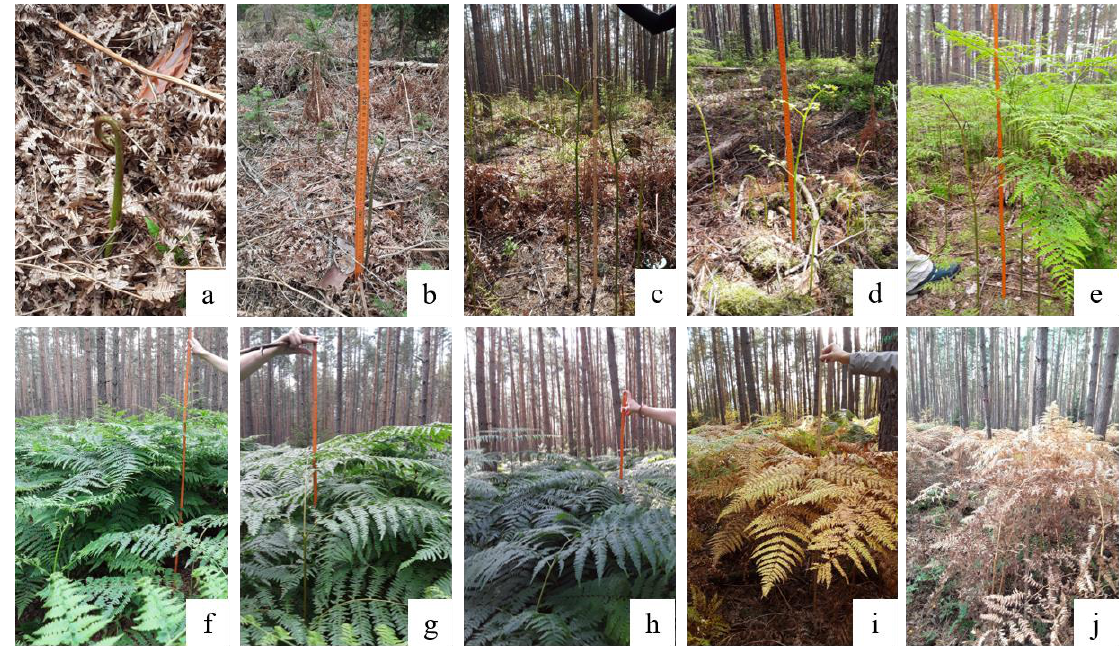
Figure 4: Phenological stages (PS) of fern in the study area at the different measurement dates: a) 14.04.2020, PS1; b) 30.04.2020, PS2; c) 15.05.2020, PS3; d) 29.05.2020, PS3; e) 17.06.2020, PS4; f) 03.07.2020, PS4, g) 23.07.2020, PS4; h) 06.08.2020, PS4; i) 30.09.2020, PS5; j) 28.10.2020,